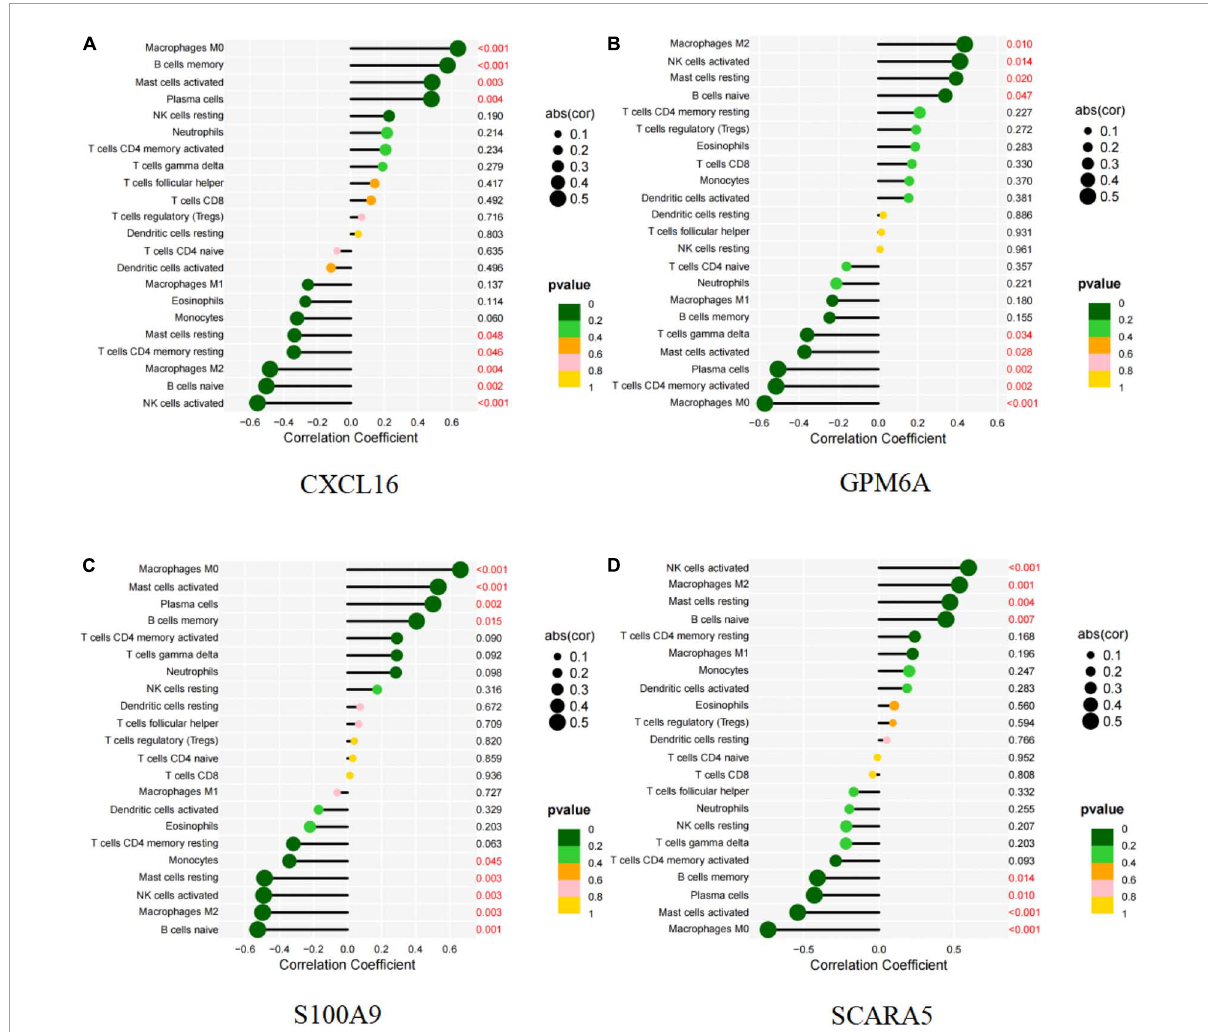
FIGURE11 Correlation between diagnostic markers and infiltrating immune cells. (A) Correlation between CXCL16 and infiltrating immune cells. (B) Correlation between GPM6A and infiltrating immune cells. (C) Correlation between S100A9 and infiltrating immune cells. (D) Correlation between SCARA5 and infiltrating immune cells. The size of the dots indicates the degree to which genes and immune cells are correlated. Correlation strength is proportional to the size of the dots. The color of the dots indicates the p -value; a yellower hue indicates a lower p -value, while a greener color indicates a higher p -value. p -value < 0.05 was considered statistically